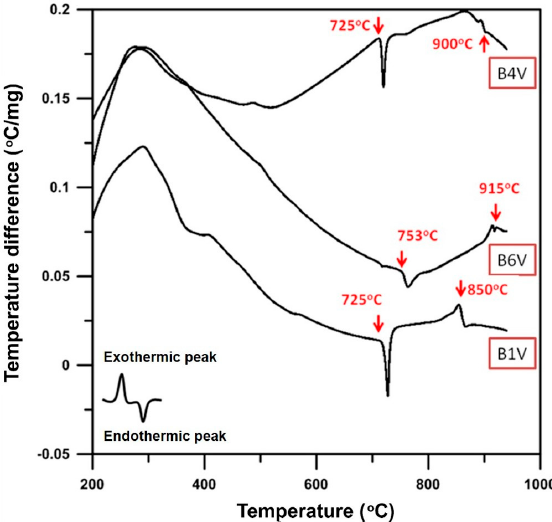
Figure 4. DTA analysis of B1V, B4V and B6V die-pressed mixtures without the thermal process.